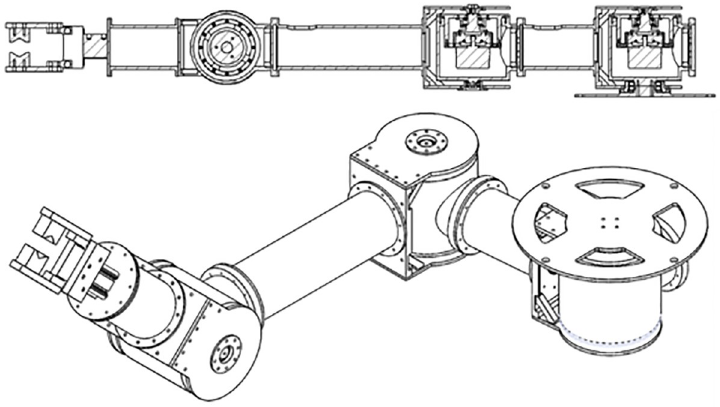
Fig 3. Assembly appearance of a manipulator.